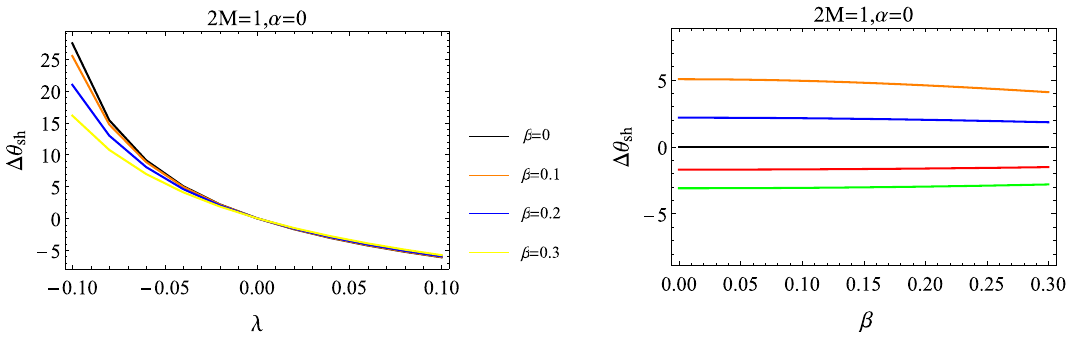
Fig. 5 Evolution of the penumbra of the black hole with the coupling constant λ and the X-cold dark matter parameter β in the Brane-World black hole